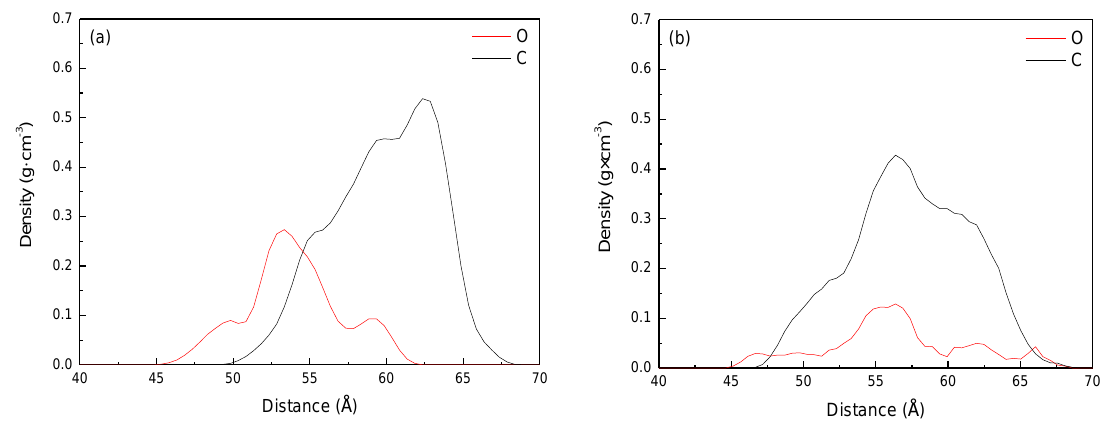
Figure 11. Density profiles of hydrophobic tails and hydrophilic head groups of collectors: ( a ) Methyl laurate; ( b ) dodecanol.